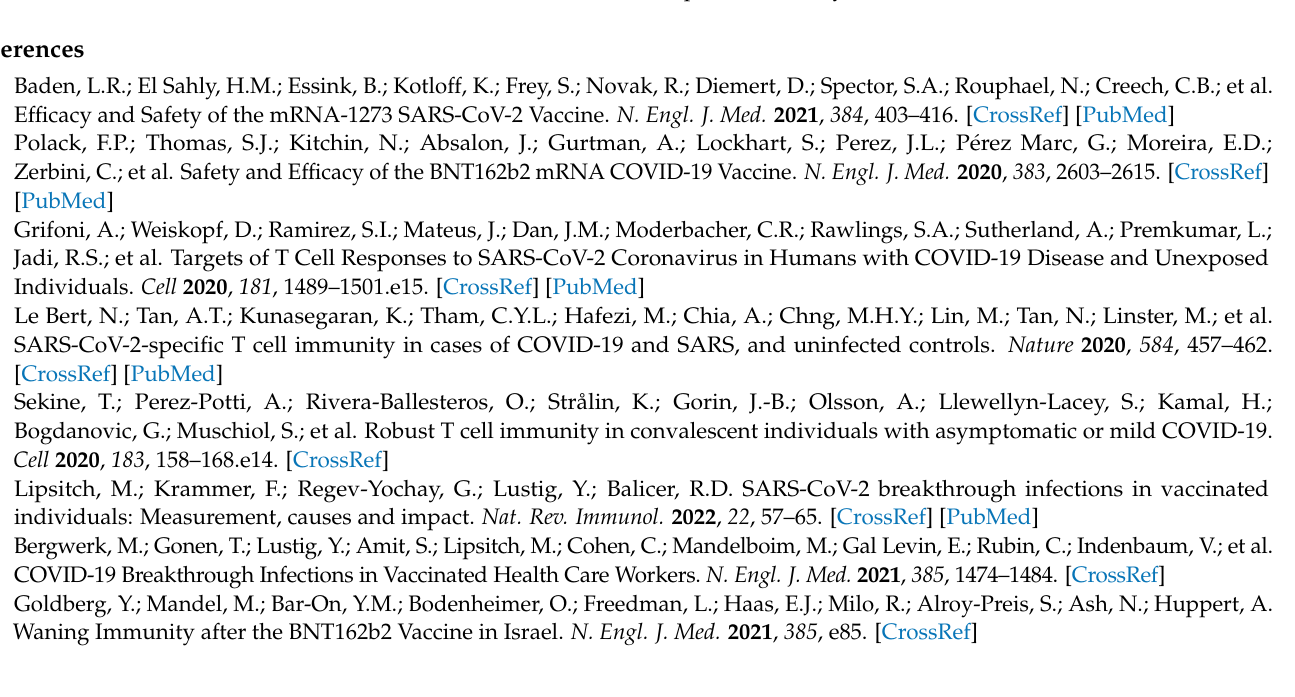
Figure S2: Flowchart of mRNA-vaccinated subjects with respect to dose and vaccine manufacturer; Figure S3: Comparison of second- and third-dose NAb durability by sex and age; Figure S4: Post hoc power analysis of paired longitudinal data set; Figure S5: NAb titers prior to breakthrough infection in groups infected before and after the onset of Omicron community spread; Table S1: Breakthrough infection population